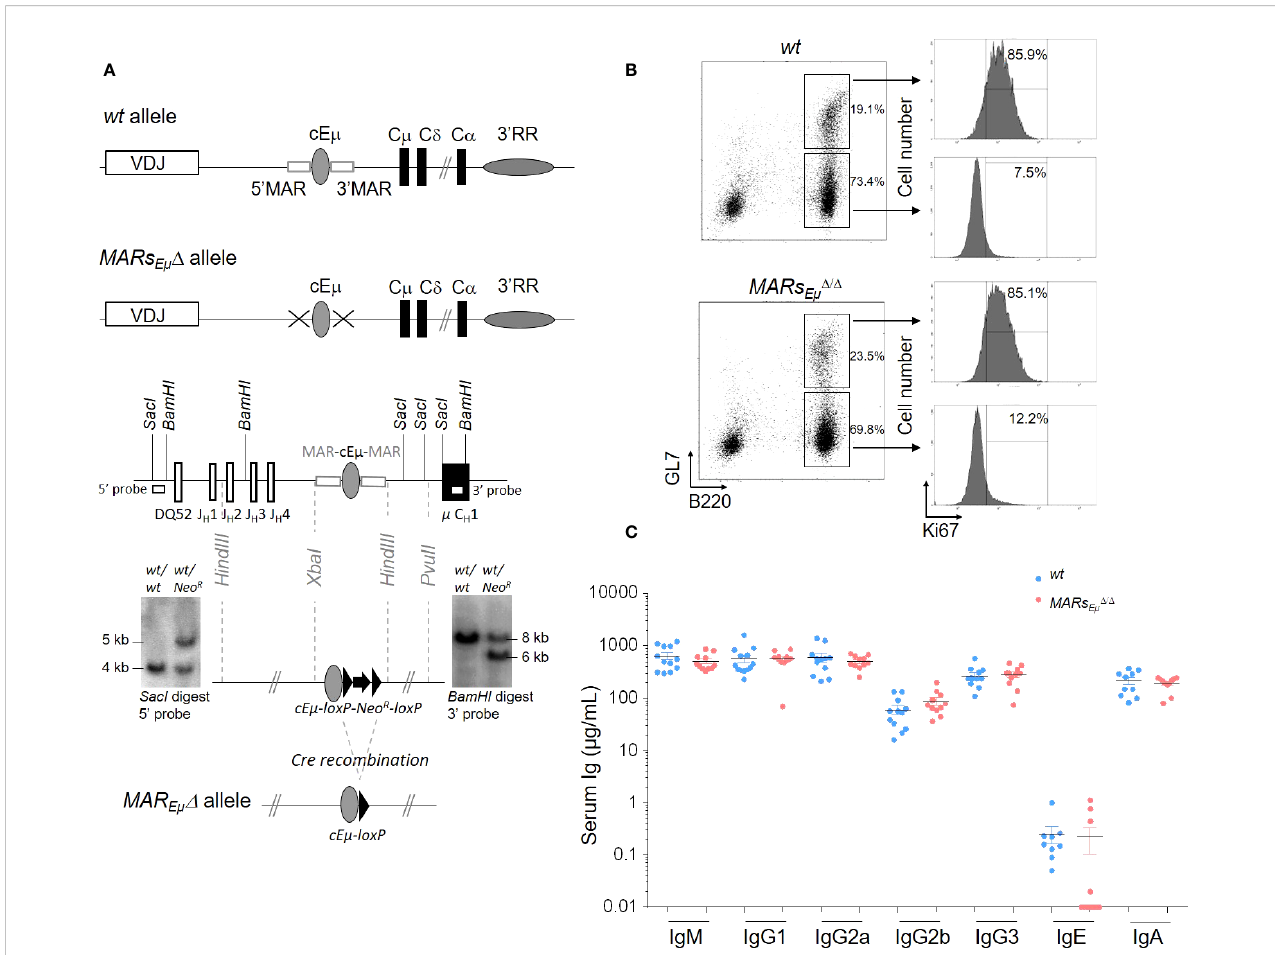
FIGURE 1 MARs Eμ deletion supports ef fi cient in vivo Ig isotype production and GC B cell development. (A) Schematic representation of wt and MARs Eμ D alleles (top). Targeting construct and Southern blot performed on recombinant ES cells with Neo R insertion. Hybridization with the 5 ′ probe detected 4 kbp and 5 kbp SacI genomic fragments respectively for wt and recombined alleles. Hybridization with the 3 ′ probe detected 8 kbp and 6 kbp BamHI genomic fragments respectively for wt and recombined alleles. MARs Eμ D allele preserved the cEμ enhancer after Cre-recombination. (B) Comparison of Peyer ’ s patch B cells subsets from wt and MARs Eμ D / D animals by fl ow cytometry: dot plots showed percentage of naïve (B220 + /GL7 - ) and GC (B220 + /GL7 + ) B cells (left panels) and, for each subset, the percentage of dividing cells (Ki67 + ) was indicated on cell count histogram plots (right panels). Experiments were performed twice with a minimum of 3 mice per group. (C) Immunoglobulin isotype secretion in sera from wt and MARs Eμ D / D mice determined by ELISA (n=9 to 12 mice, mean ±